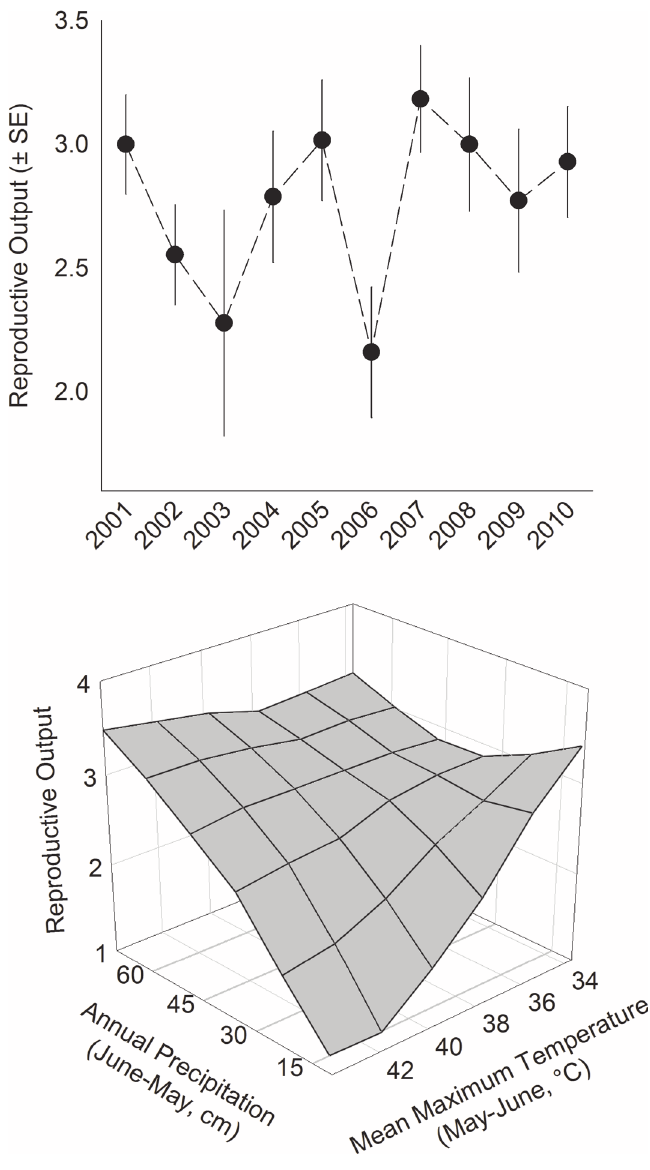
Fig 5. Temporal variation and effects of weather on reproductive output of ferruginous pygmy-owls in northwest Mexico, 2001 – 2010. Temperature and precipitation were measured at regional scales and estimates are from model 8 in Table